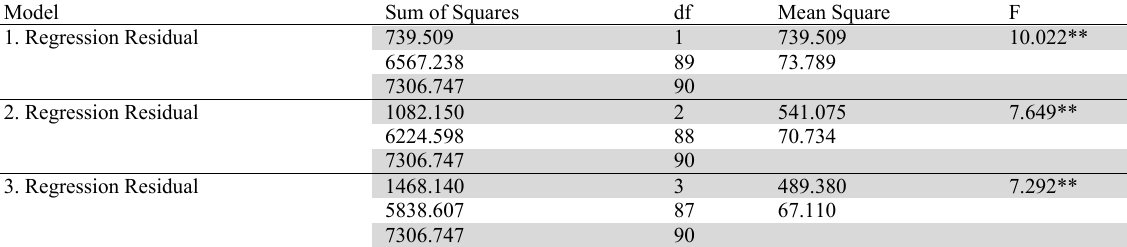
The results of ANOVA test